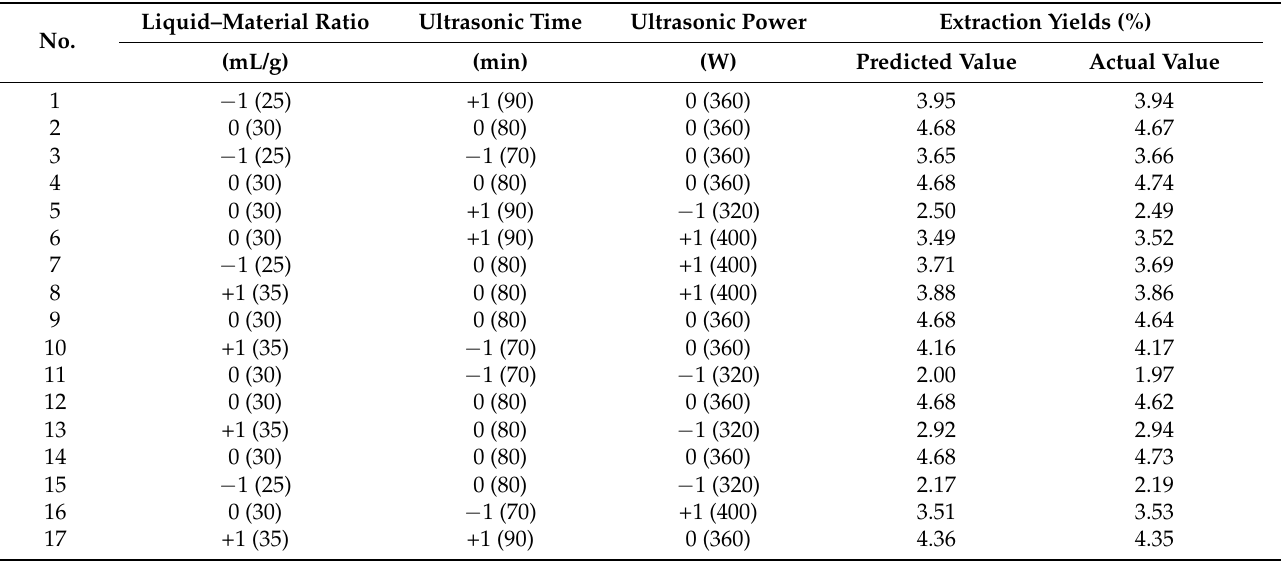
Table 2. Predicted and actual extraction yields of